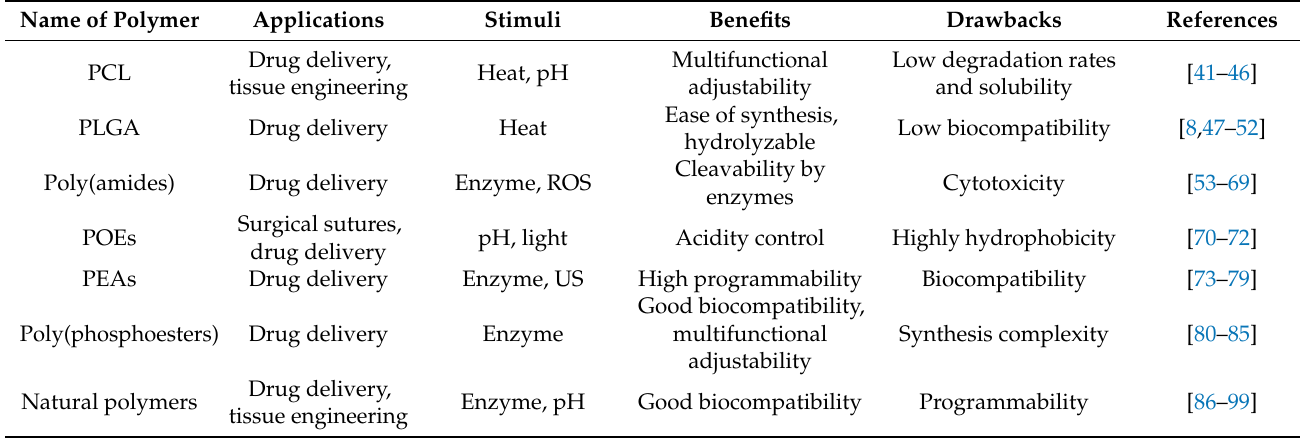
Table 1. Polymers for drug delivery